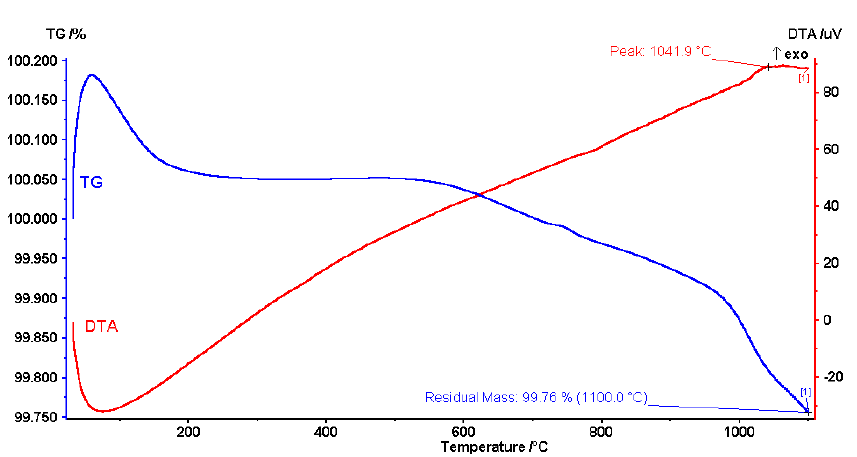
Fig. 3 TG and DTA curves of prepared pigment Al 0 . 3 La 0 . 7 P 3 O 9 (mass: 275 mg).